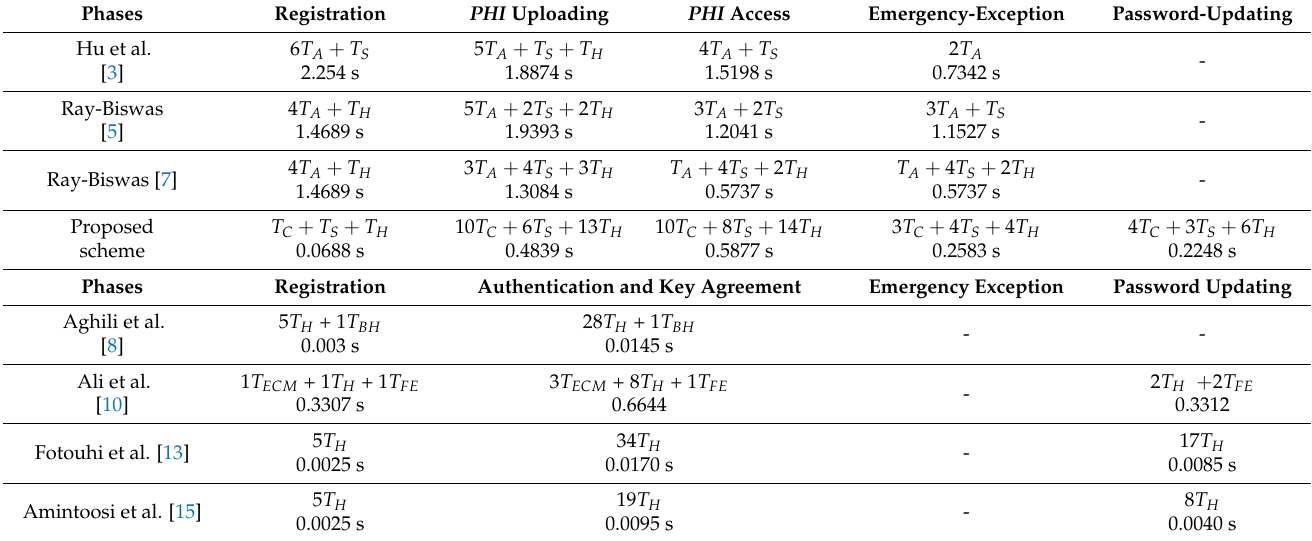
Table 3. Performance